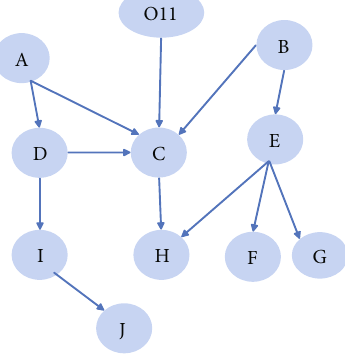
Figure 4: Directed acyclic graph.